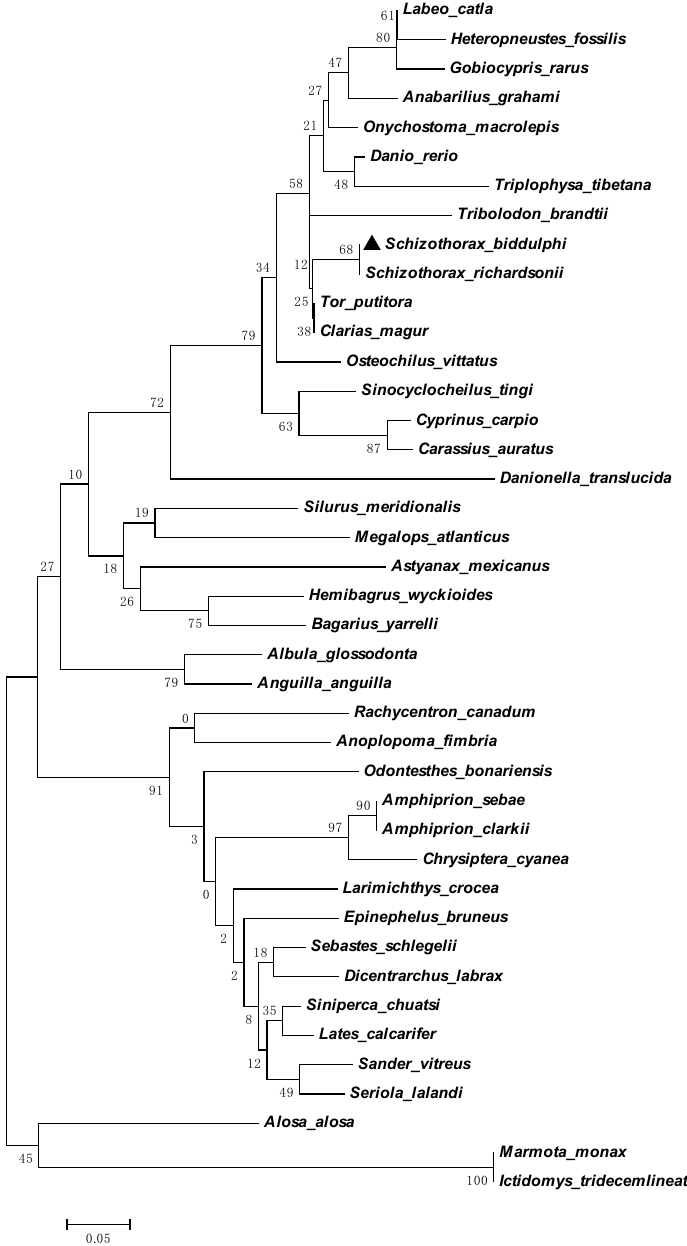
Figure 2. Phylogenetic tree analysis of the kiss1 protein in different species. The number shown at each branch indicates the bootstrap value (%). GenBank accession numbers see Table 2.